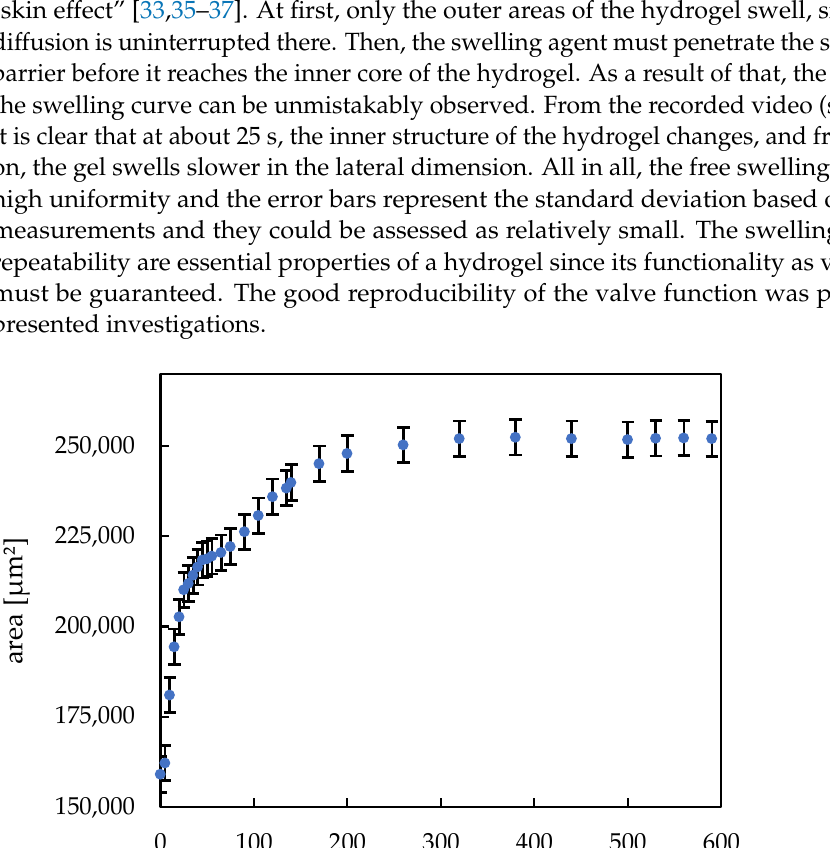
( c ) Figure 11. ( a ) Side view during pneumatic cartridge dispensing printing process, the upper part is the tip of the metallic nozzle of the pneumatic extruder and below is a 500 µm hole in a PMMA foil. ( b ) Top view of PEG printed and solidified in a hole. ( c ) Dependence of opening time on diameter of holes (d OV ) and thickness (h VS ) of PMMA foil.